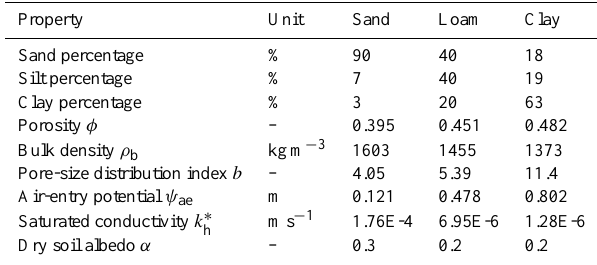
Table 2. The yearly averaged values of the surface soil moisture, the surface soil temperature and the surface energy balance components of the simulated